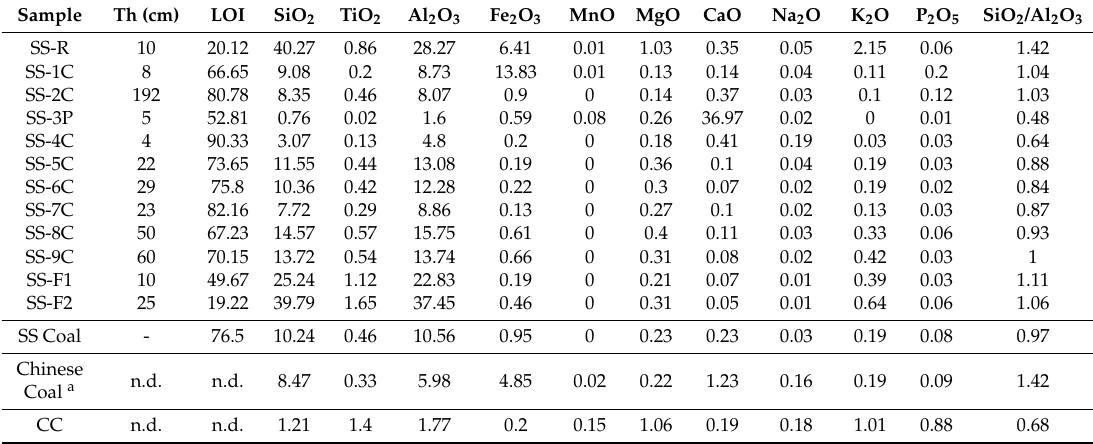
Table 2. Percentages of major-element oxides in the Songshao coal, parting, roof and floor rocks.